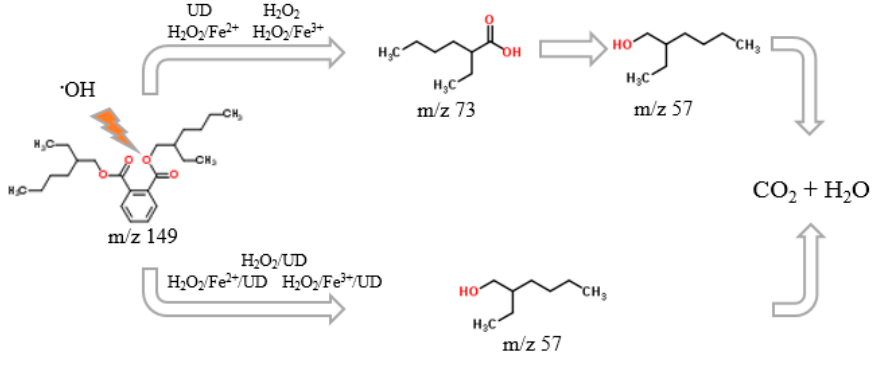
Figure 13. The DEHP degradation pathway.